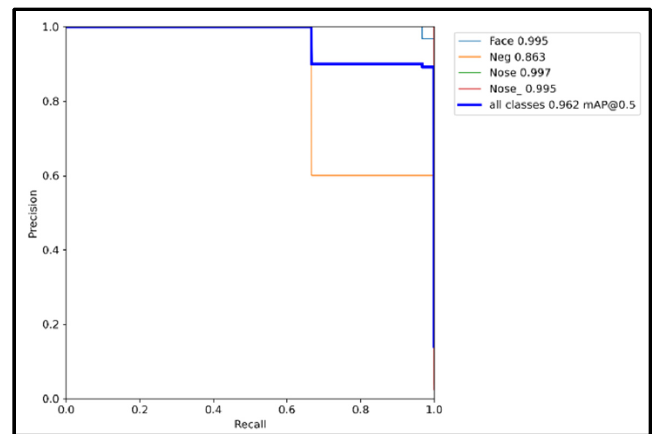
Figure 5. Precision-Recall Curve of Transfer Learning.